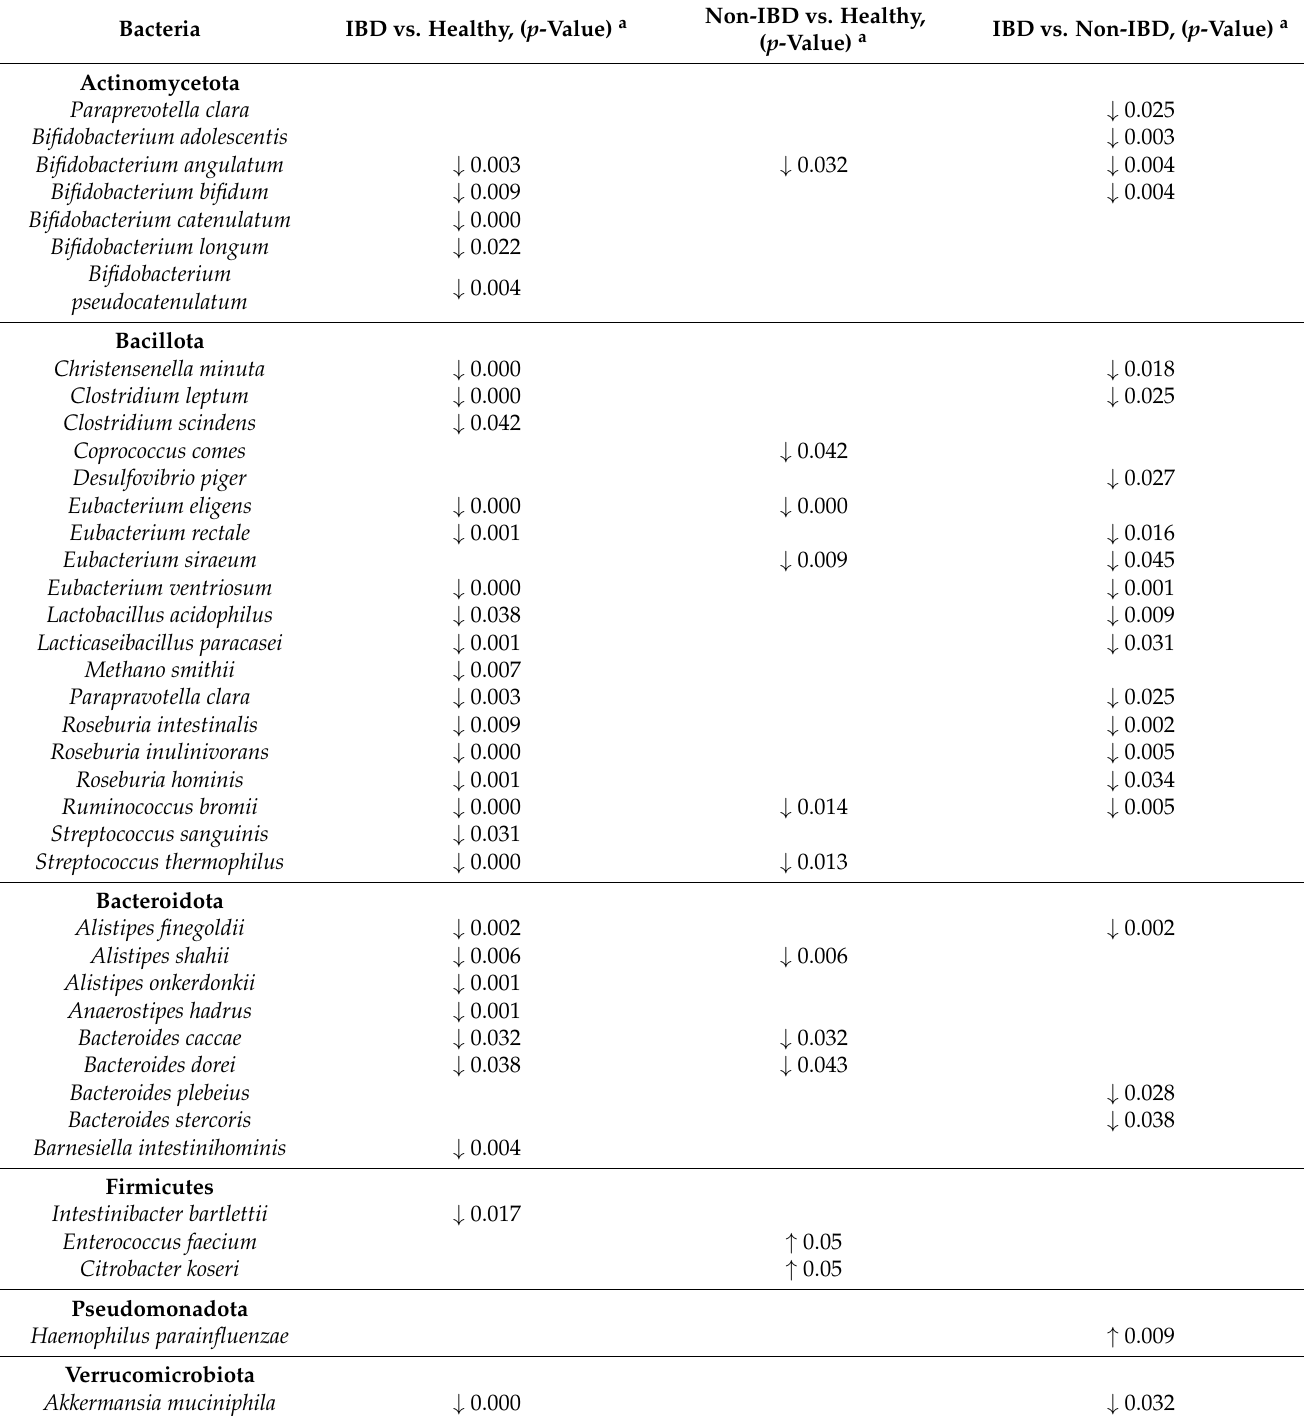
Table 2. Bacterial species exhibiting deviating abundances between patient and control